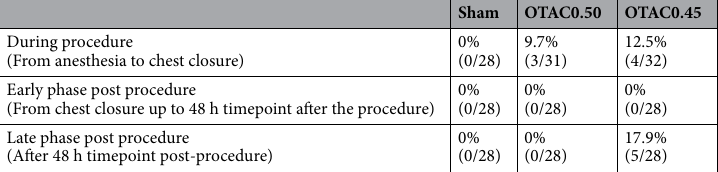
Table 2. The mortality rate during and post procedure. The mice were performed sham procedure (Sham) or O-ring-induced transverse aortic constriction (OTAC). O-rings had inner diameters of 0.50 mm (OTAC0.50) and 0.45 mm (OTAC0.45).